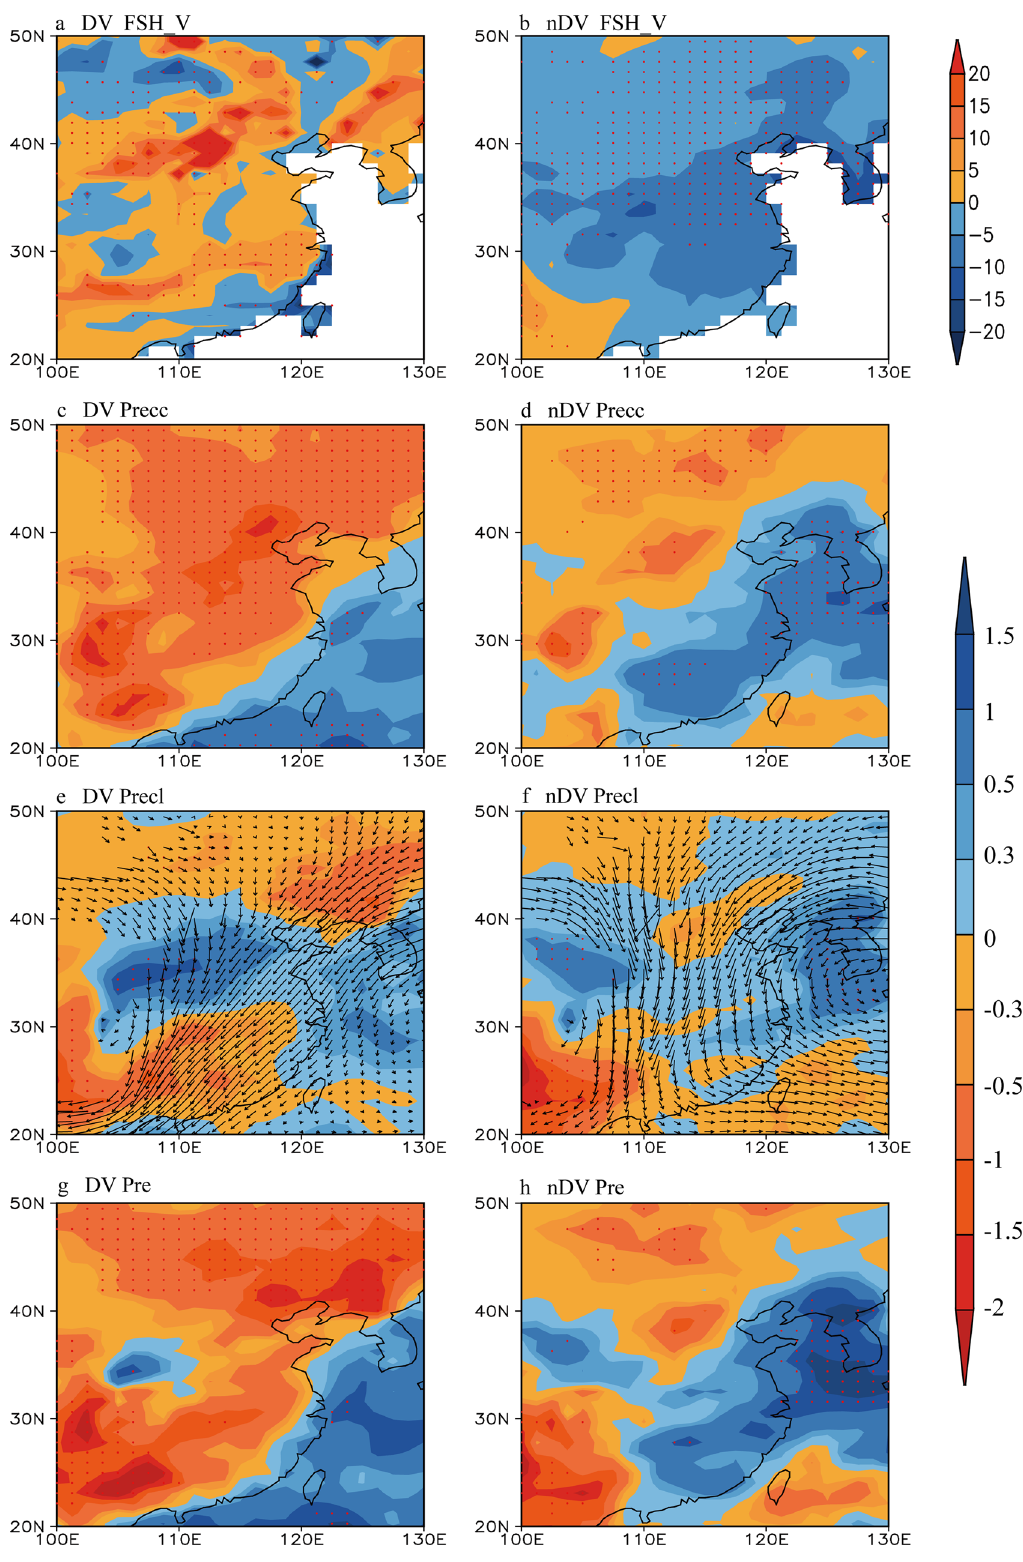
Fig. 6 Changes in modern summer sensible heat fl ux (W/m 2 ) and precipitation (mm/day) compared with early Holocene at 9 kyr BP. a , b DV and nDV simulated FSH_V; c – h Same as a , b but for convective precipitation (Precc), stratiform precipitation (Precl) and total precipitation (Pre), respectively. e , f also show JJA wind fi eld changes at 850 hPa. These fi gures are generated using GrADS v1.5.1.12 71 .